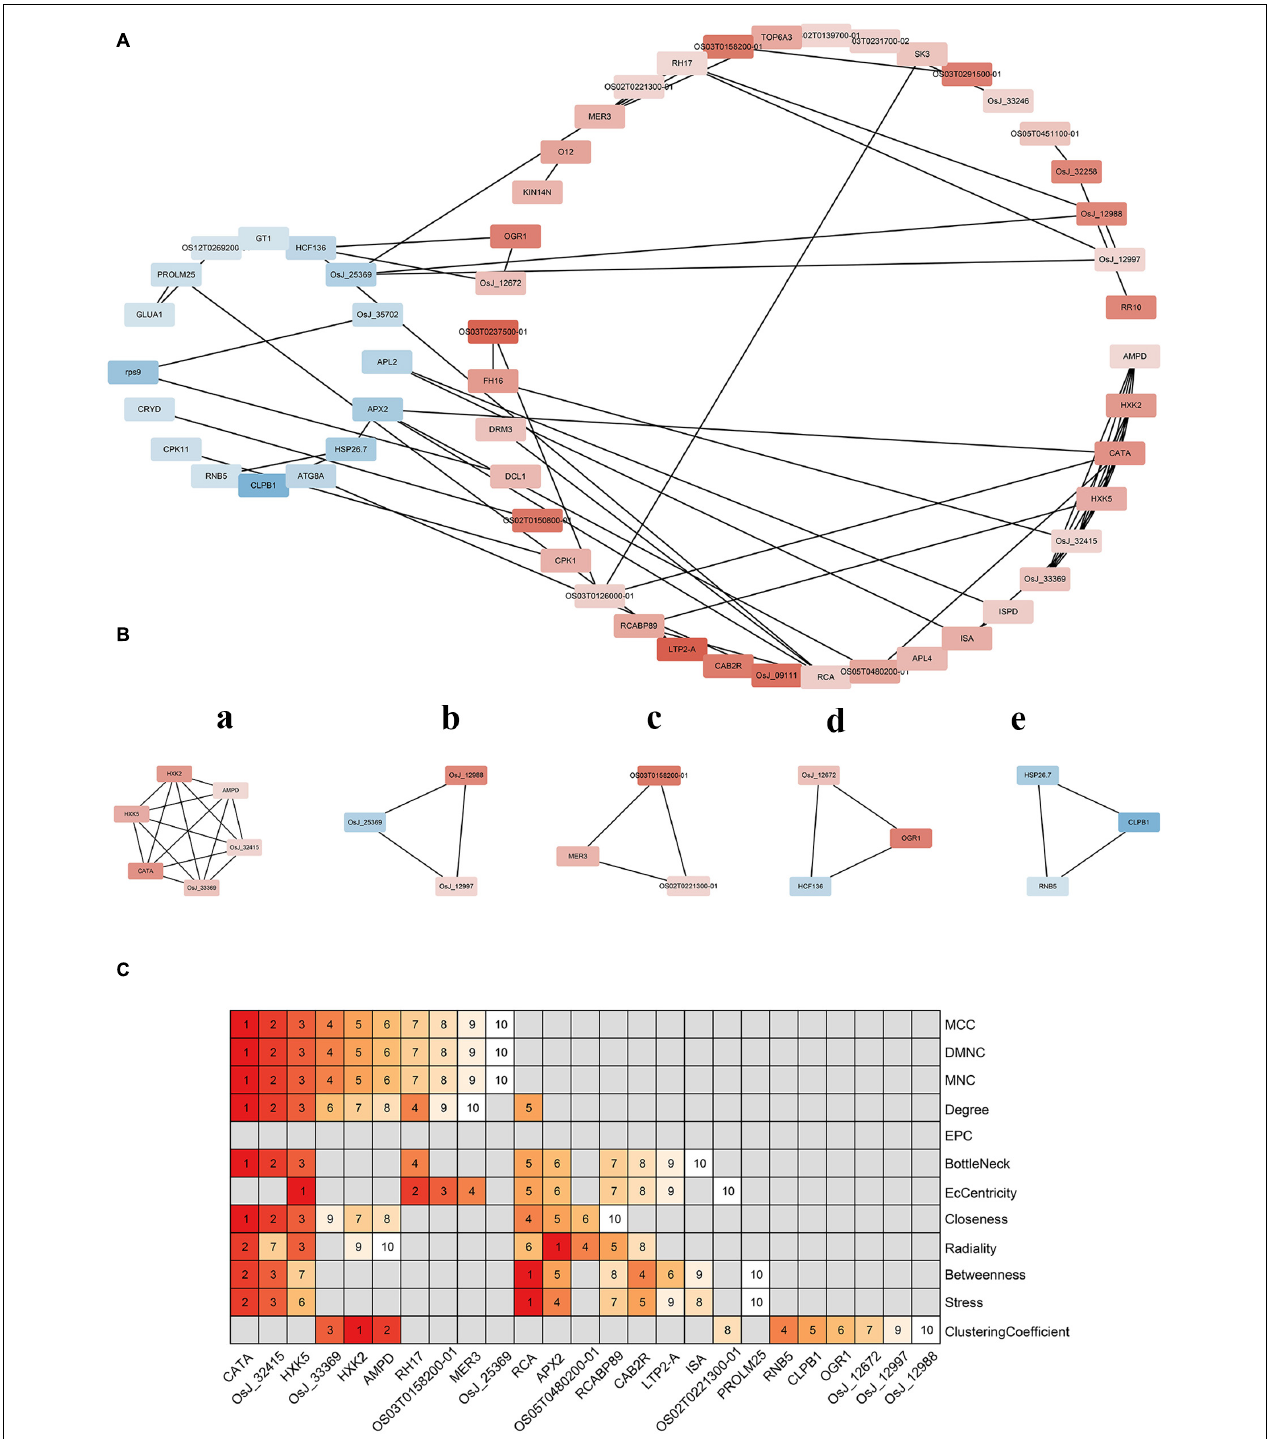
FIGURE 7 | Protein interaction network analysis of differentially expressed genes. (A) Protein interaction regulatory network of differentially expressed genes. The up-regulated genes and down-regulated genes were divided into two groups. The deeper the red, the greater the expression; the darker the blue, the smaller the expression. (B) The important sub-modules of protein–protein interaction network are expressed in lowercase English letters according to the score. a has the highest score and e has the lowest score. (C) Key genes in protein–protein interaction network. On the right is the method of screening genes. The top 10 genes were sorted according to the score of each method. The higher the score, the higher the ranking.